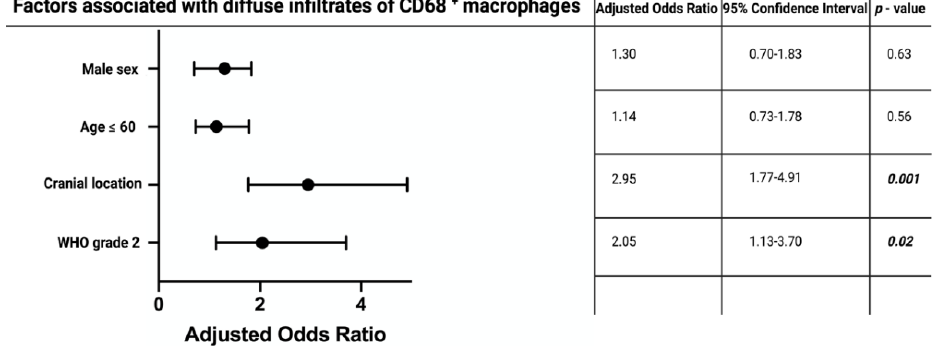
Figure 4. Forest plots from multivariable binary logistic regression analysis: cranial meningioma location, and WHO grade 2 are independent predictors of increased density of CD68 + macrophage infiltrates. p -values in italics and bold outline statistically significant results.